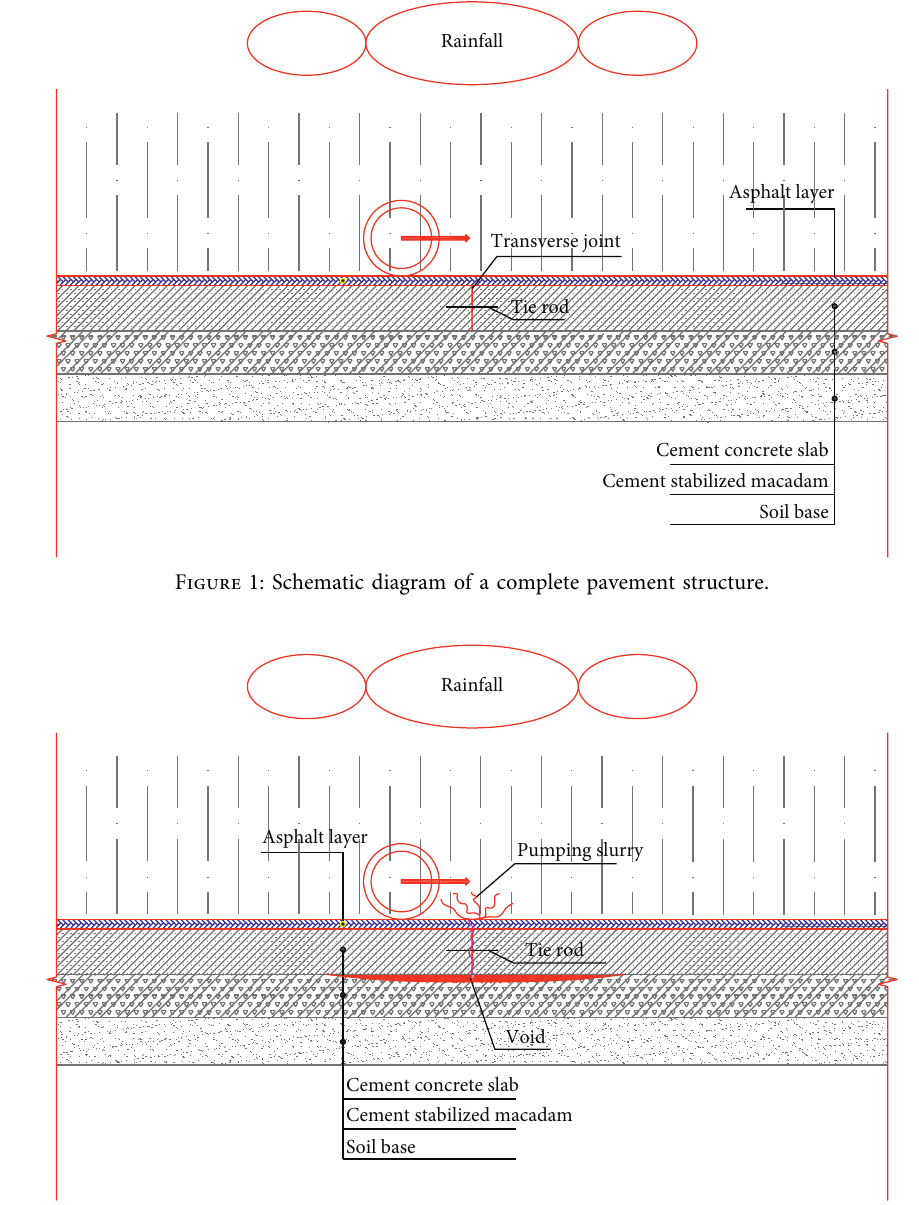
Figure 2: Schematic diagram of a pavement structure with voids.